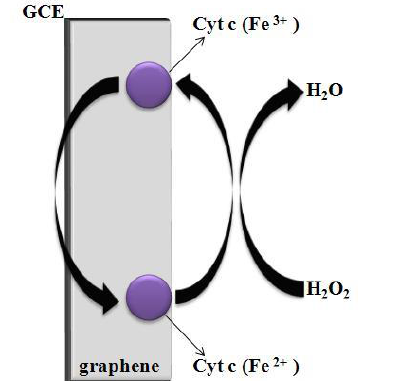
Scheme 1. Representation of electron transfer between immobilized Cytc and Cyt c-nafion-GR/GC electrode during electrocatalytic activity for the reduction of H O (b). Scheme 1: Representation of electron transfer between immobilized Cytc and Cyt c-nafion- 2 2 GR/GC electrode during electrocatalytic activity for the reduction of H 2 O 2 .